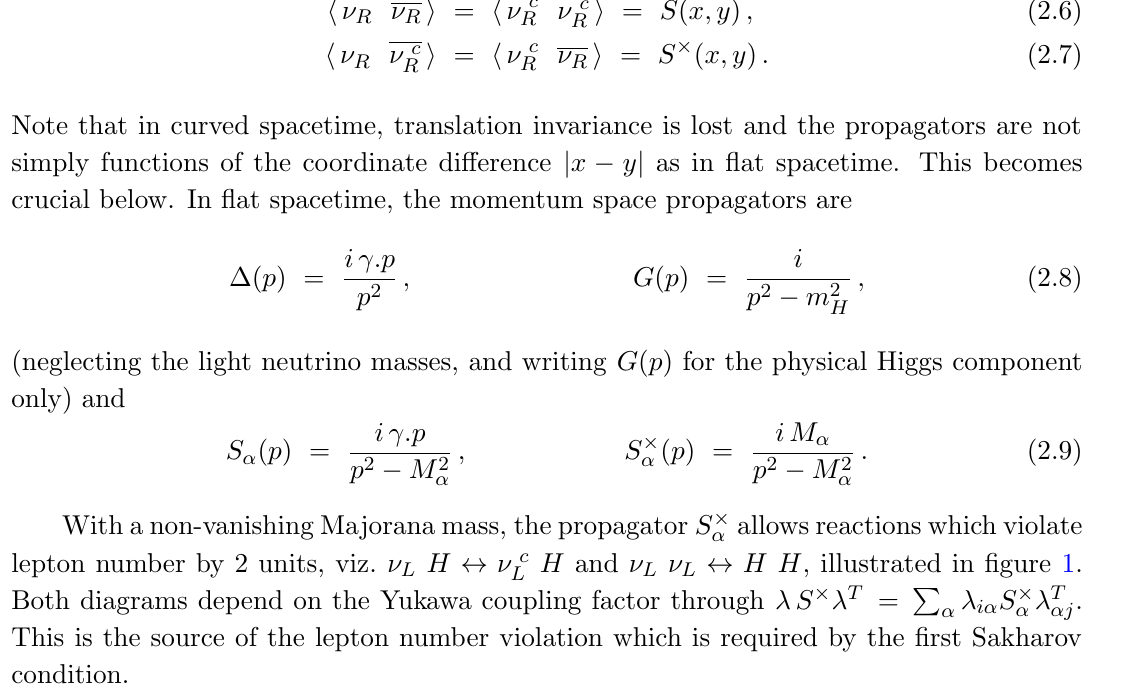
The corresponding propagators are denoted